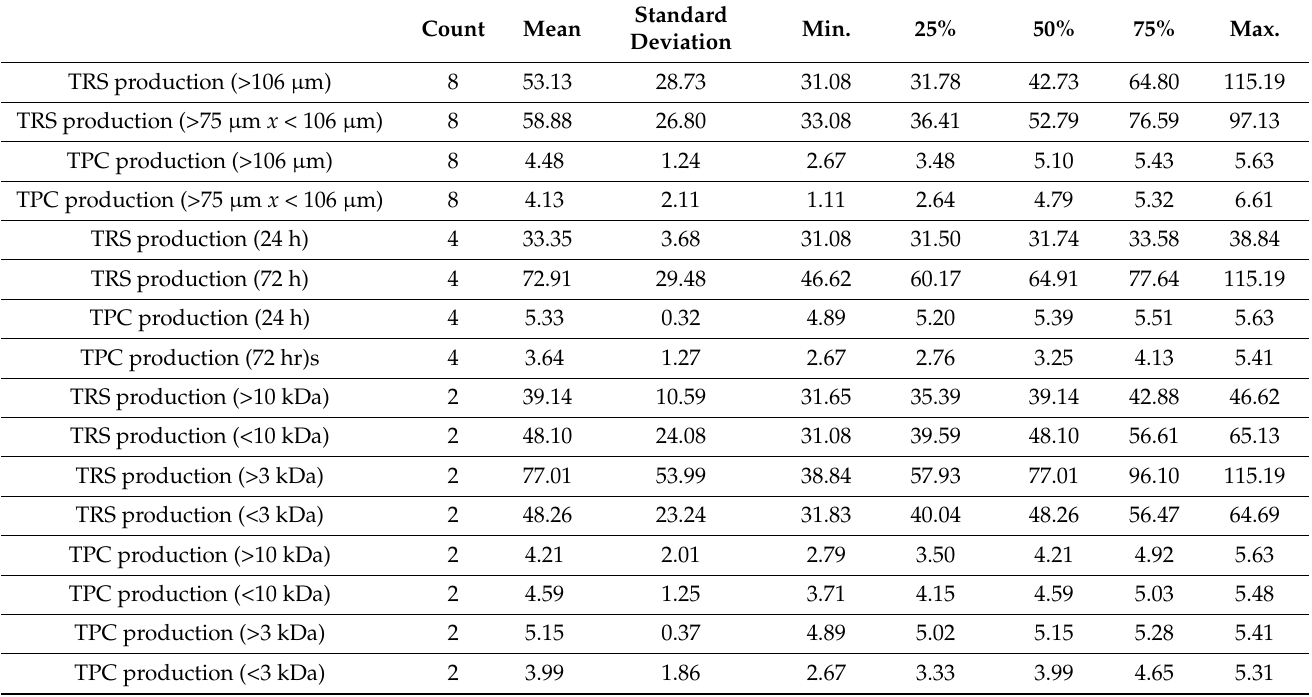
Table 4. Statistical summary of the study with respect to the parameters assessed, providing stan- dard deviations to inform the validity of the distribution for the production of TRSs and TPCs for each